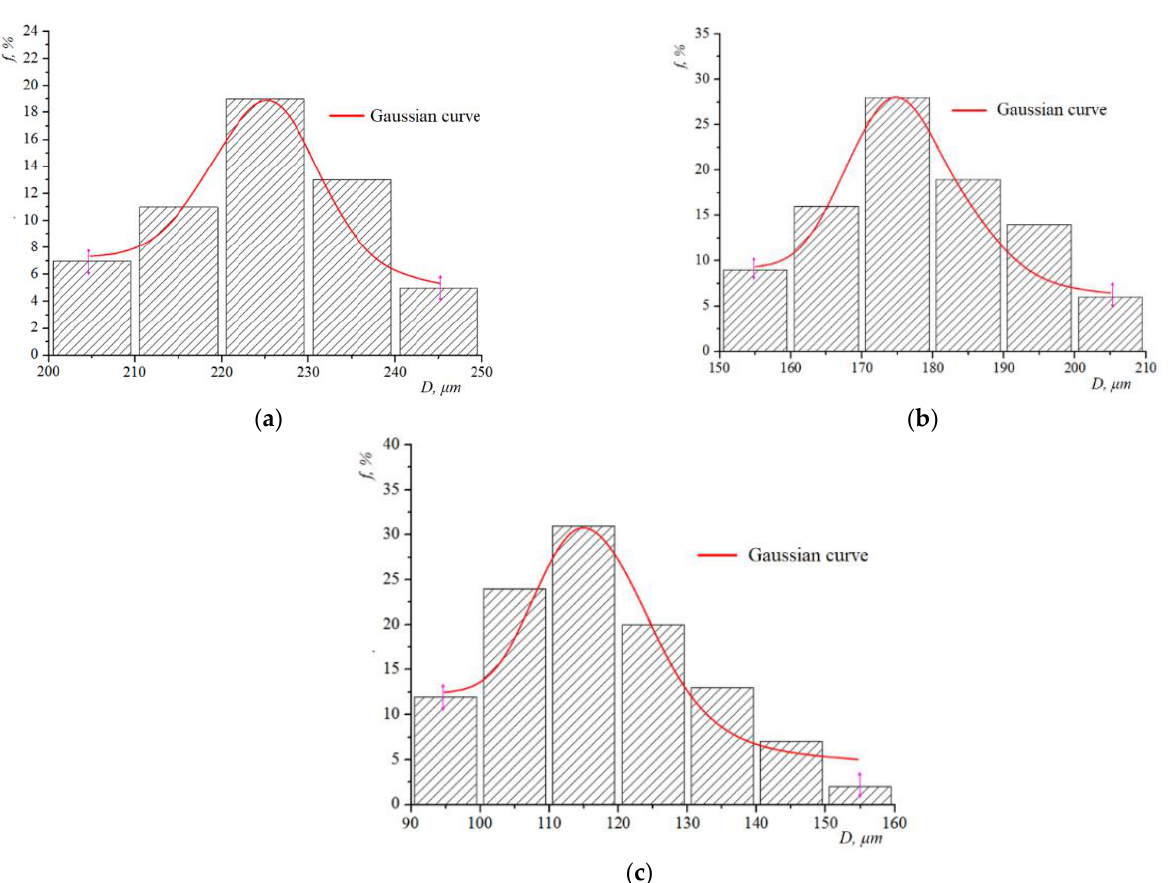
Figure 4. Gaussian curves for distributions of powder alloy VT20 particles corresponding to various fractions after hydrogenation-dehydrogenation: ( a ) 200–250 microns, ( b ) 160–200 μm, ( c ) 100–160 μm.